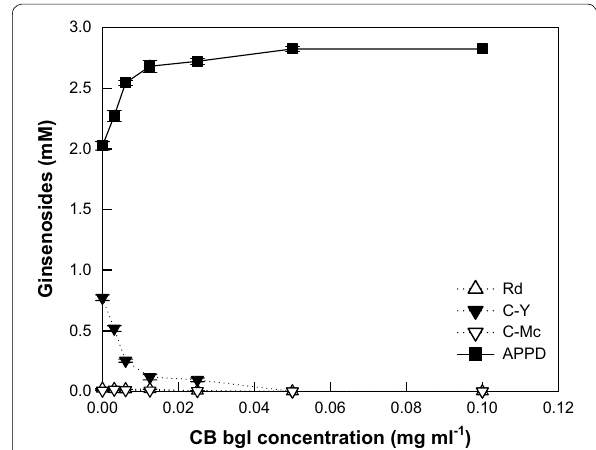
Fig. 2 Determination of the optimal concentration of CB‑bgl for the complete conversion of the remaining PPD‑type ginsenosides in the reaction solution after a 3‑h reaction with DT‑bgl for the biotransfor‑ mation of 2.8 mM PPD‑type ginsenosides in ginseng root extract to APPD. Data represent the means of three experiments and error bars represent the standard